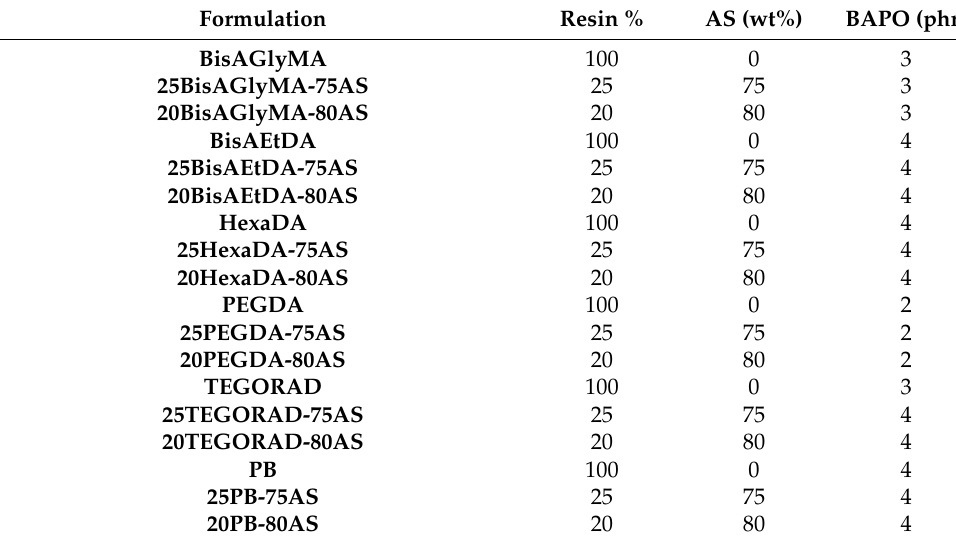
Table 1. Composition of the formulations